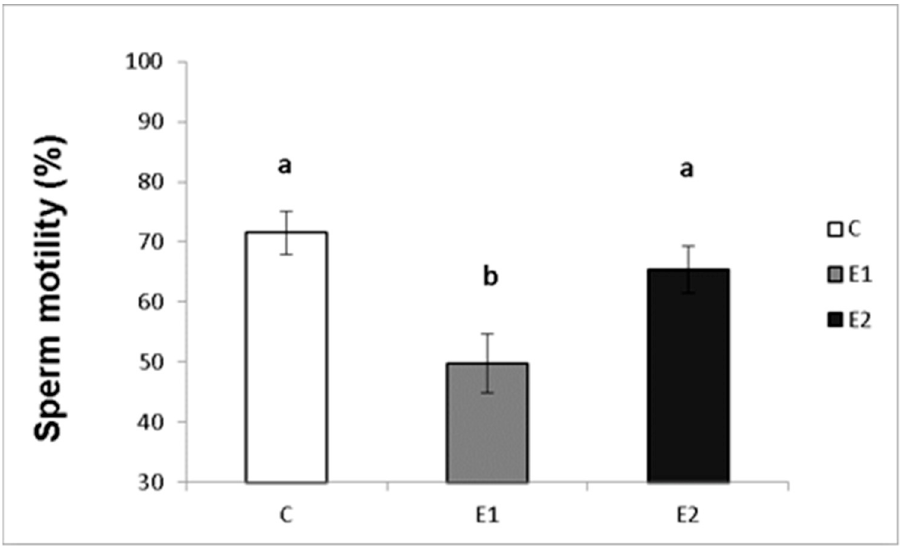
Figure 5. Sperm total motility in rabbits fed with green tea. C (without dietary green tea). E1–5 g green tea/100 kg normal food. E2–20 g green tea/100 kg normal food. Values and error bars express means ± SEM. a vs. b—difference is significant at p < 0.05.